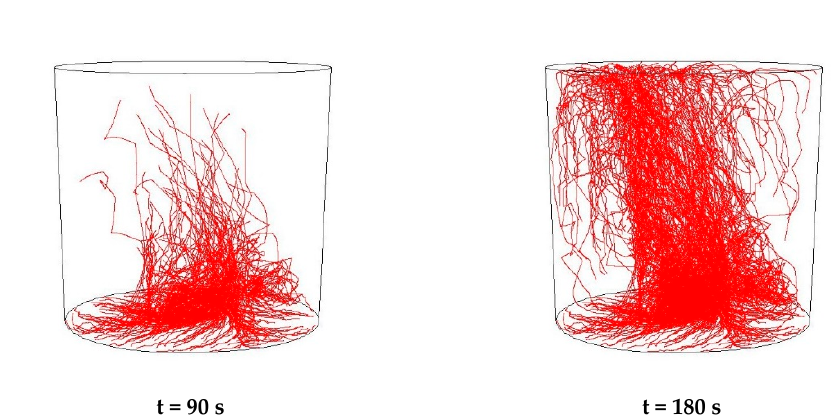
Figure 14. Trajectories of non-metallic inclusions MnS for the case of argon flow of 50 L/min for the particle diameters of ( a ) 18 µm and ( b ) 27 µm in the 42CrMo4 steel.